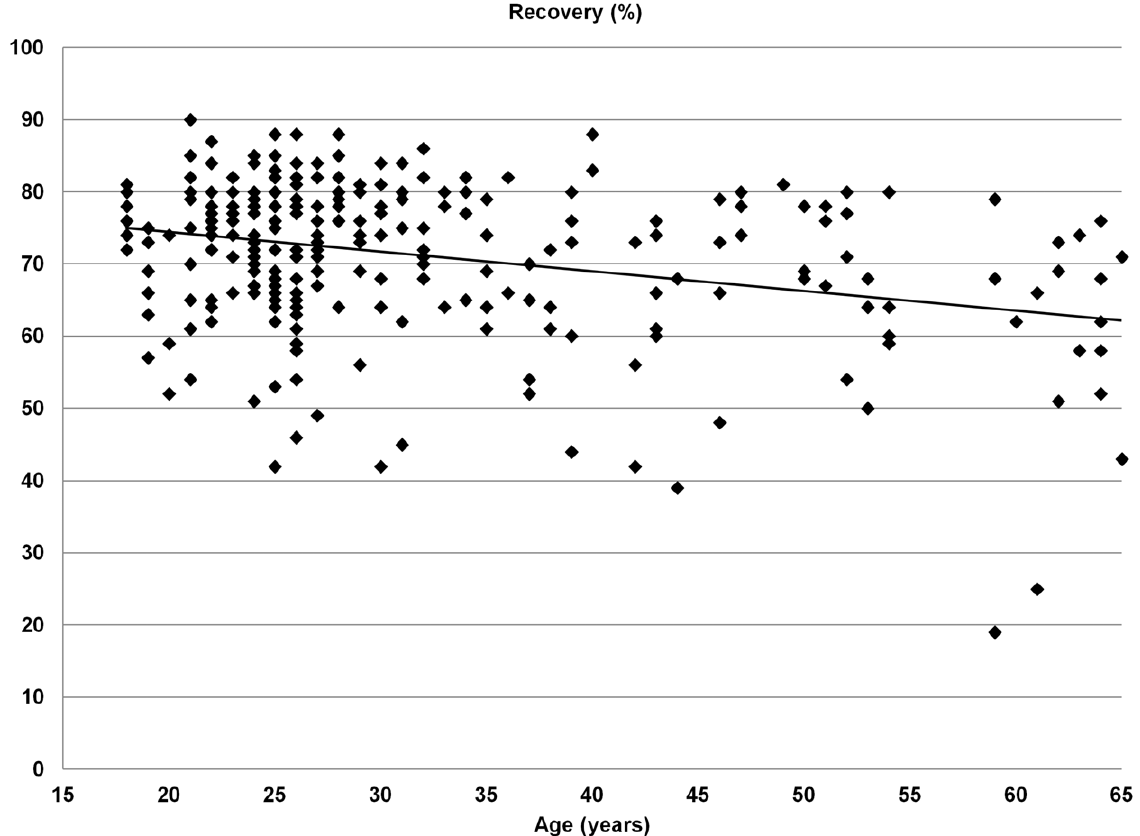
Figure 1. Correlation with age for bronchoalveolar lavage fluid recovery (y-axis) in healthy never-smoking subjects.